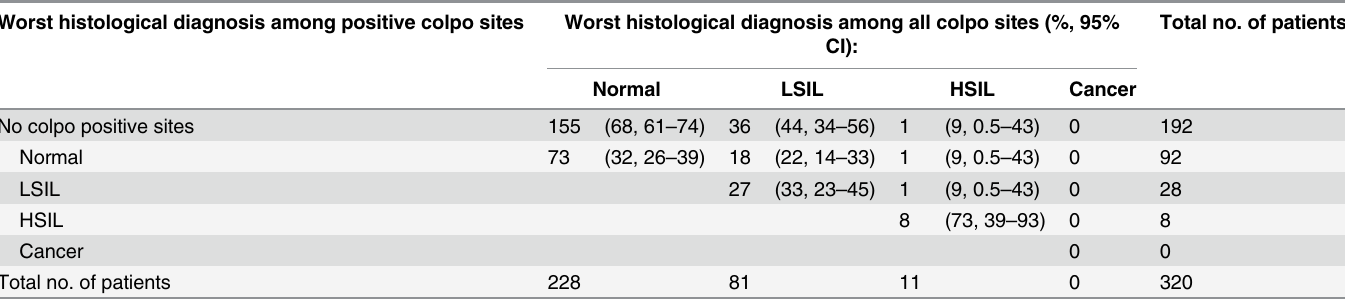
Table 7. Comparison of worst histological diagnosis among sites diagnosed as positive by colposcopy with worst overall histological diagnosis for the 320 Houston diagnostic patients with a negative study Papanicolaou smear diagnosis. Worst histological diagnosis among positive colpo sites